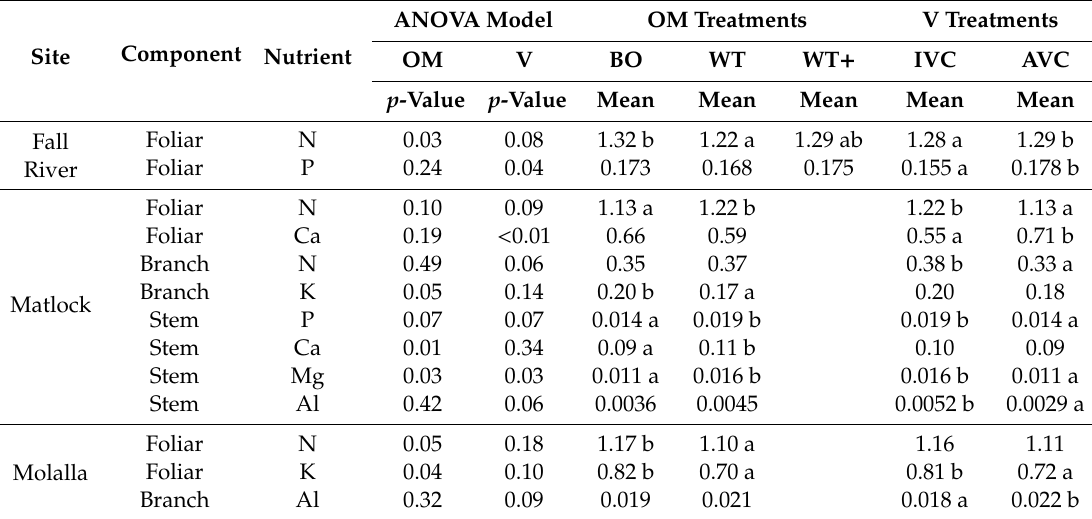
Table 4. Significant treatment e ff ects on Douglas-fir nutrient concentrations at Fall River, Matlock, and Molalla. Treatment means with di ff erent lowercase letters were significantly di ff erent ( p < 0.10) between organic matter (BO, WT, WT + ) or vegetation control treatments (IVC, AVC). All nutrient concentration values are shown as